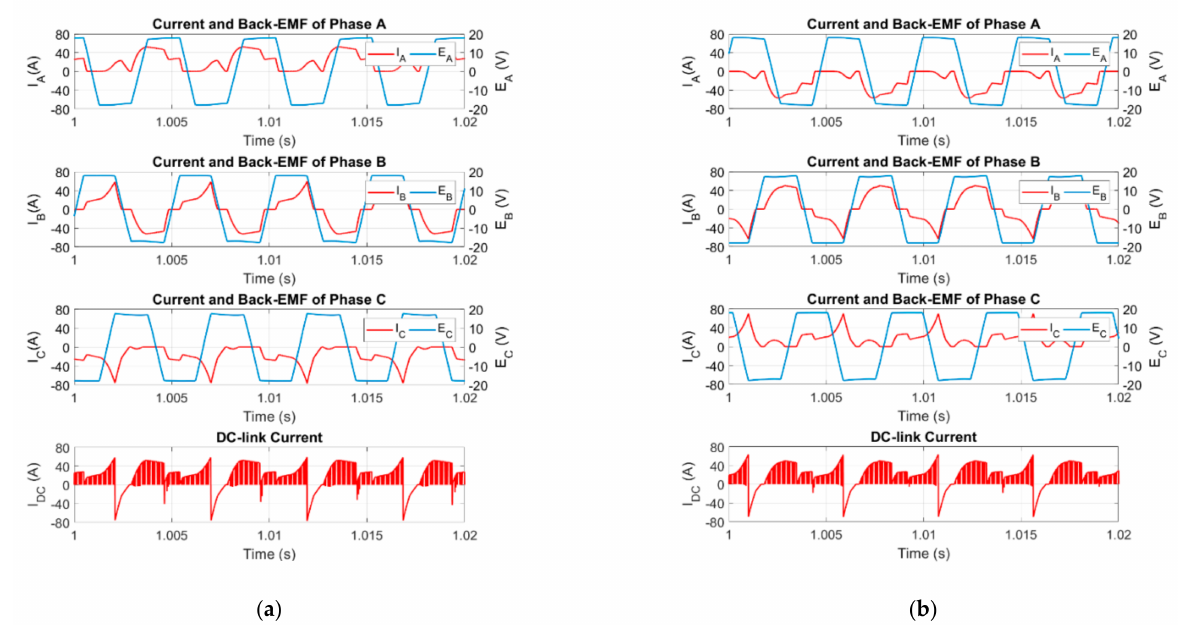
Figure 9. Phase currents and back-EMF voltages along with the DC-link current in case of rated speed and load under Hall-effect position sensor A failure. ( a ) Defective sensor A at high state; ( b ) Defective sensor A at low state.